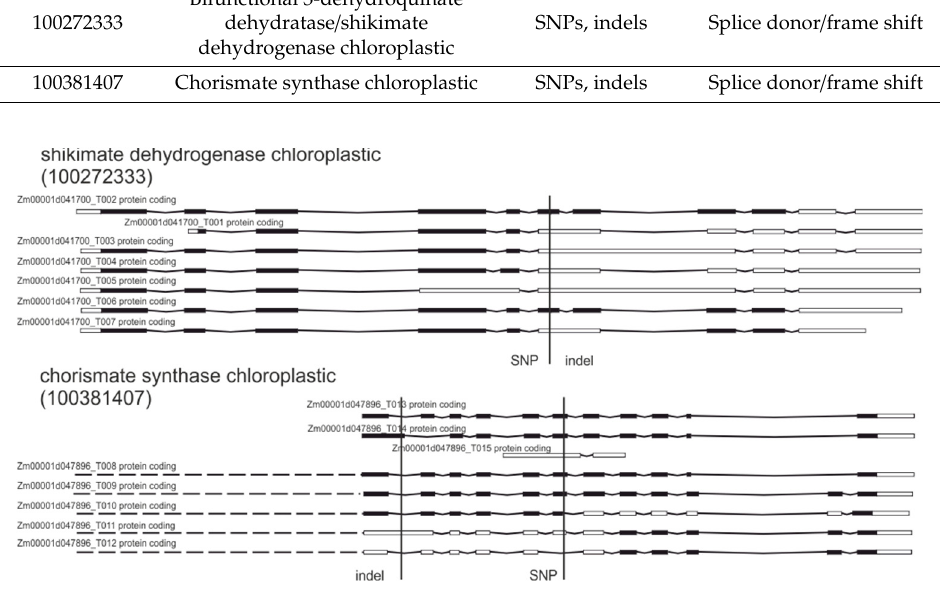
Figure 4. Genetic variations in genes encoding proteins involved in shikimate pathway.